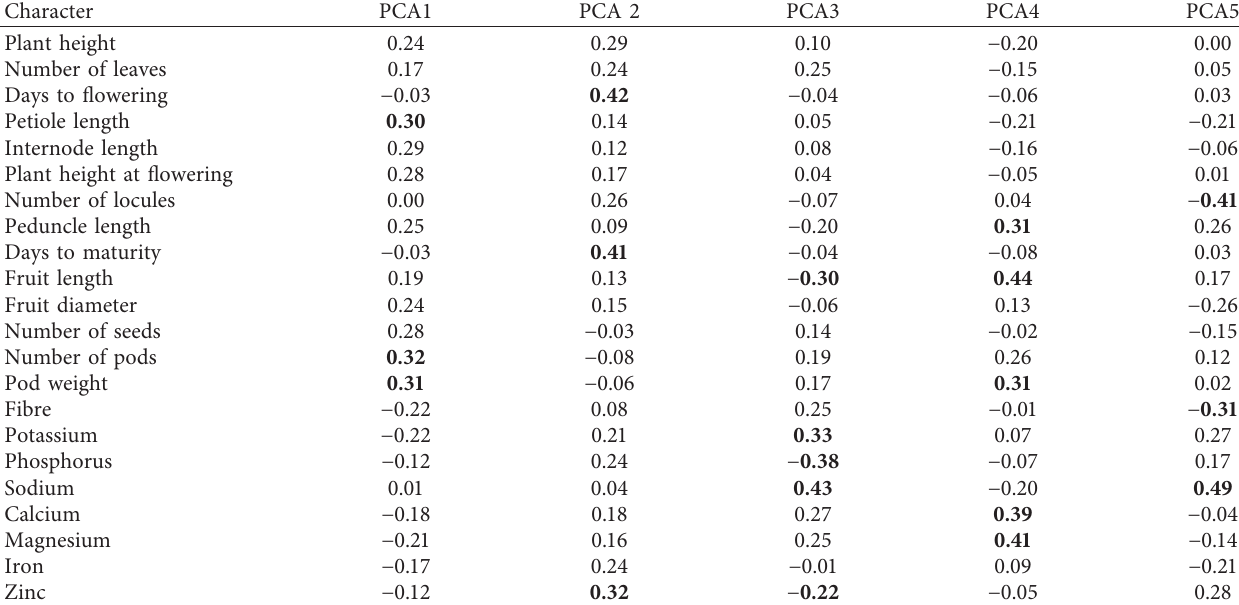
Table 5: The five principal component axes and their characters.